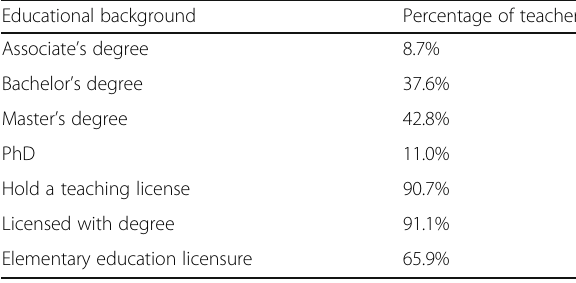
Table 1 Percent of teachers by educational